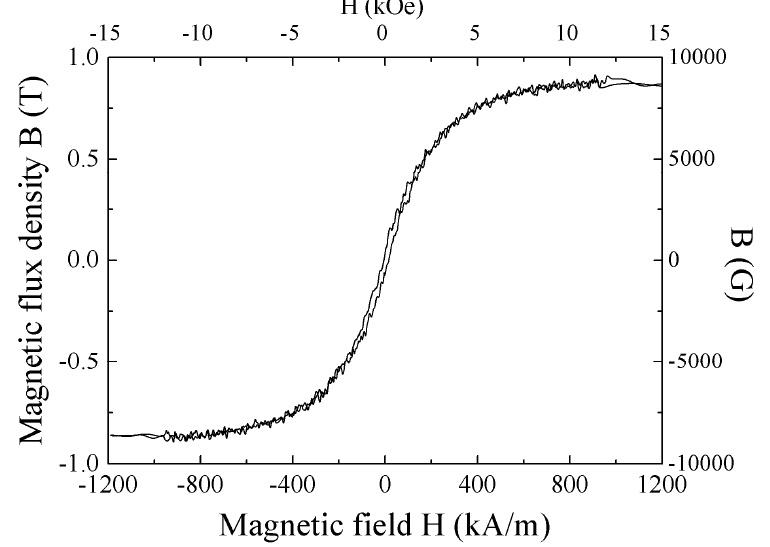
Figure 22. Measured M-H loop of φ 200 μ m diameter soft magnetic particle [21].